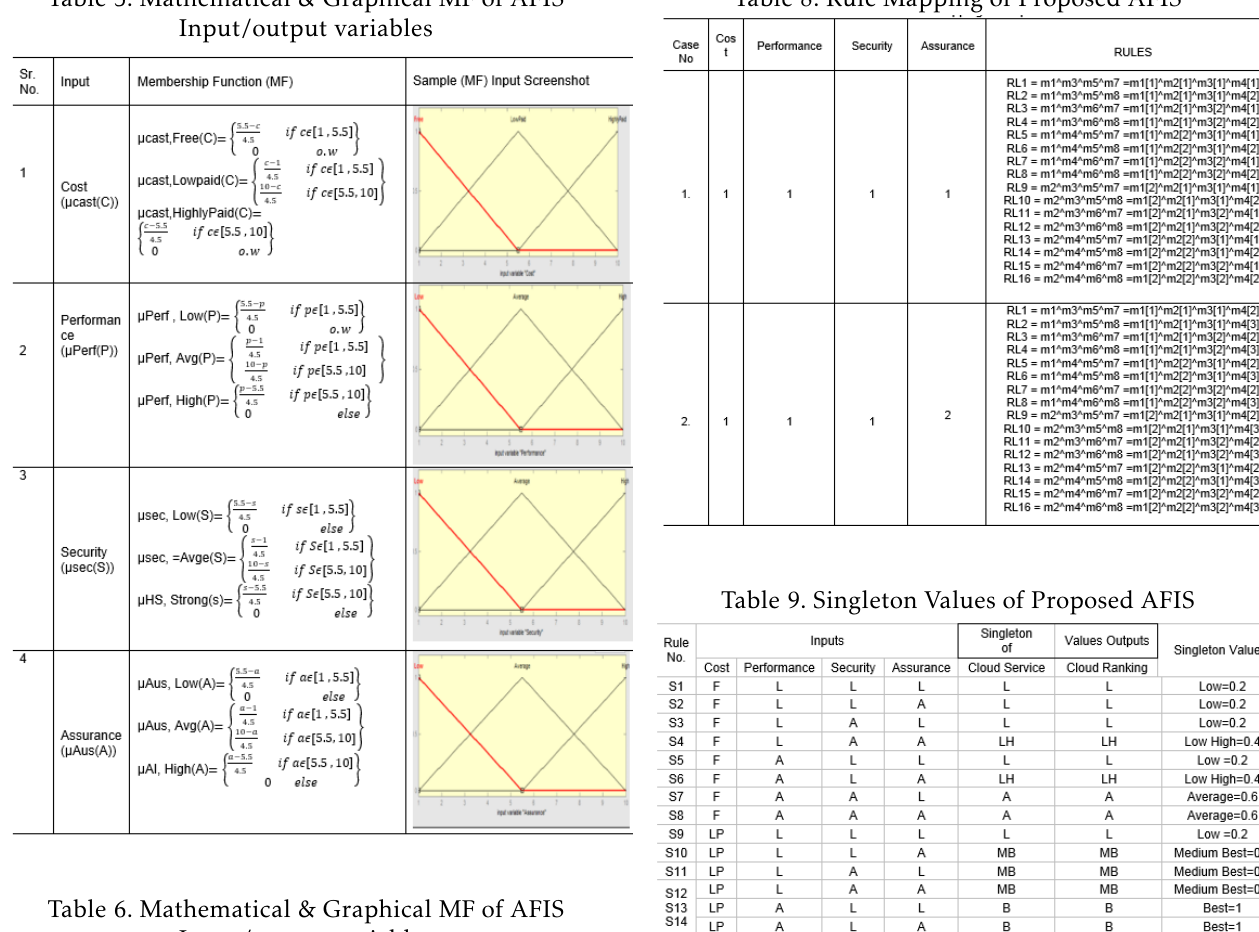
Table 8. Rule Mapping of Proposed AFIS